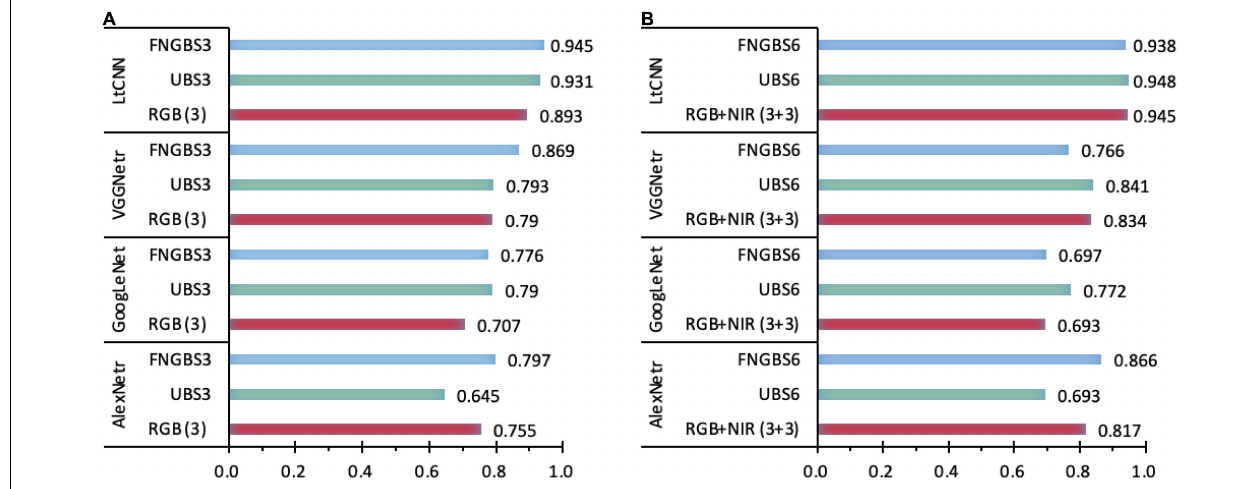
FIGURE 11 | A comparison of the sensitivity of spectral bands for species classification in the four CNN models. Charts (A,B) show the kappa coefficients with 3-band and 6-band classifications recommended by the band selection methods. A considerable difference of kappa values in any classifications with different datasets indicates higher sensitivity of the CNN models.